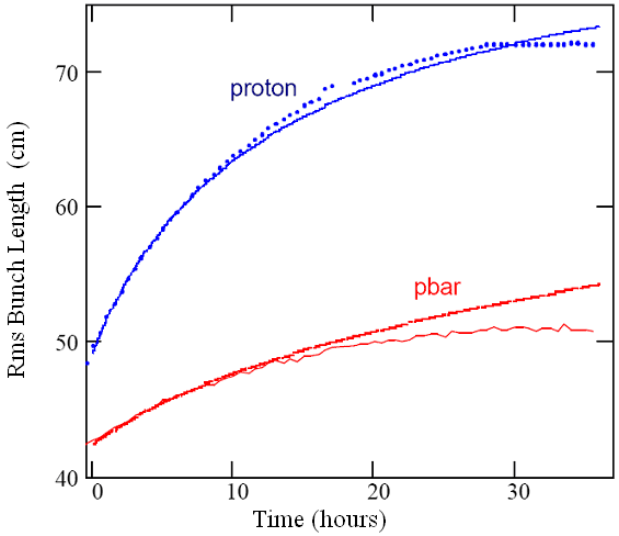
FIG. 4. (Color) Simulated bunch lengthening effects compared with the measurements of a typical store